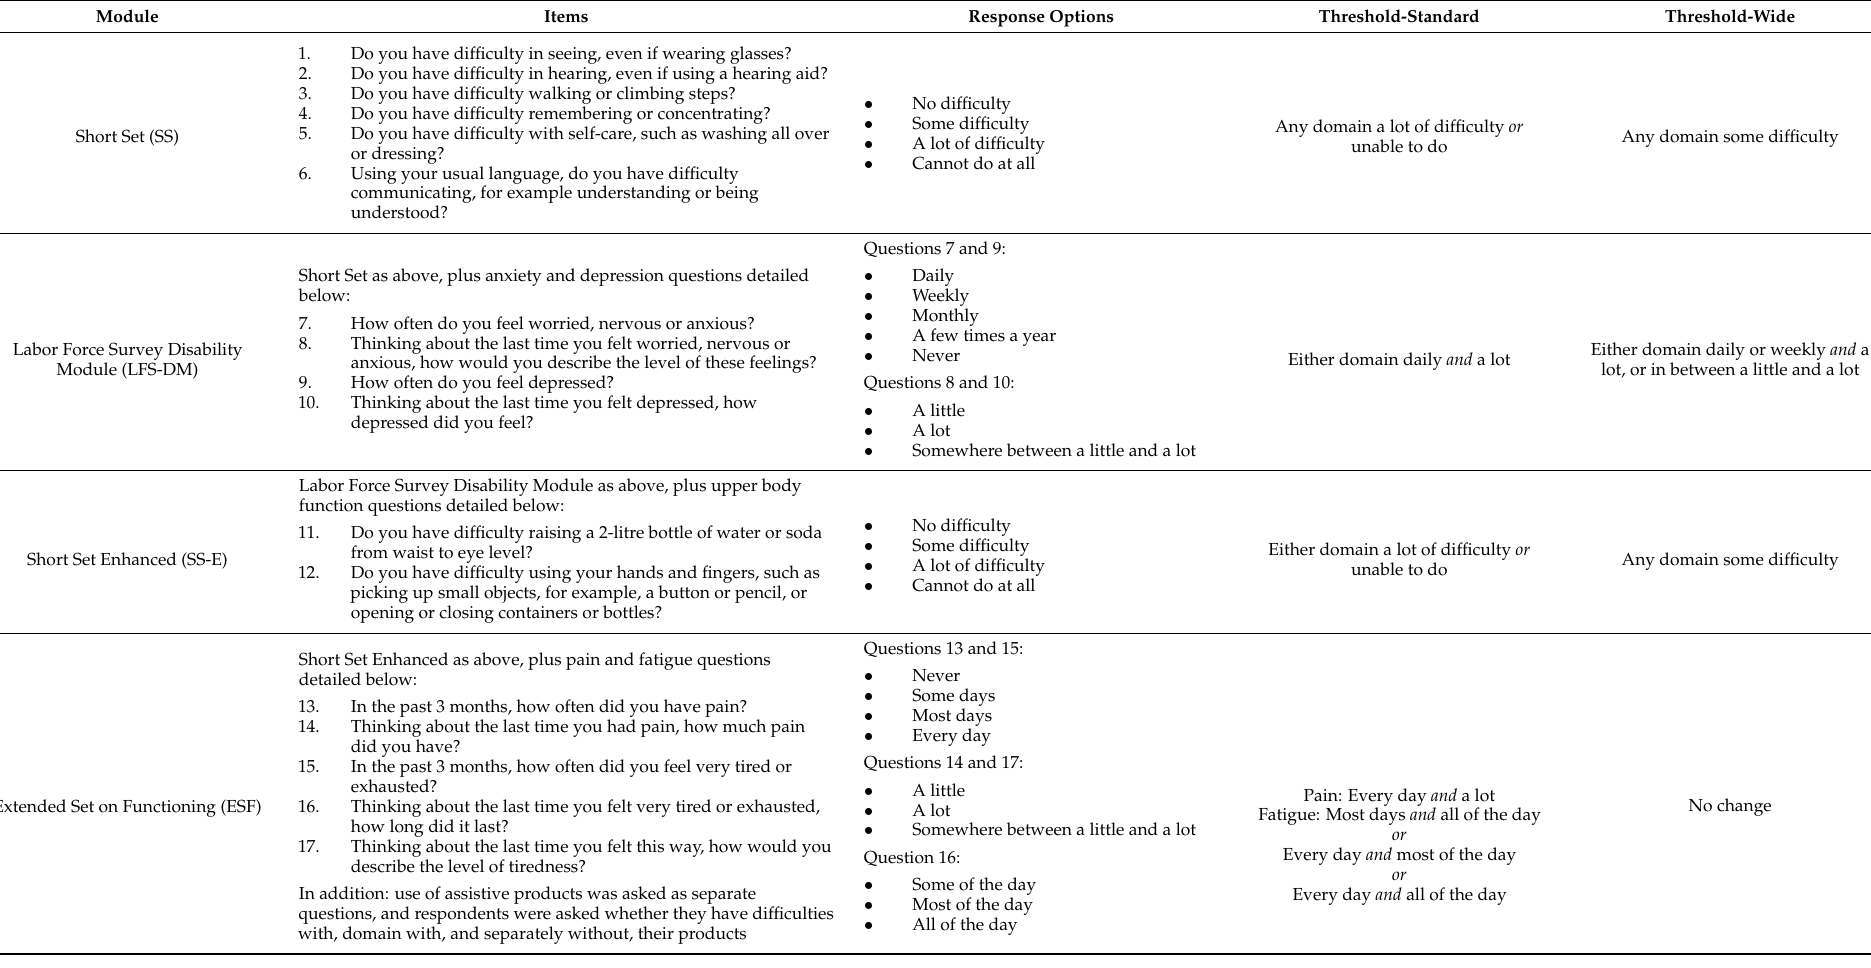
Table 1. Washington Group modules and